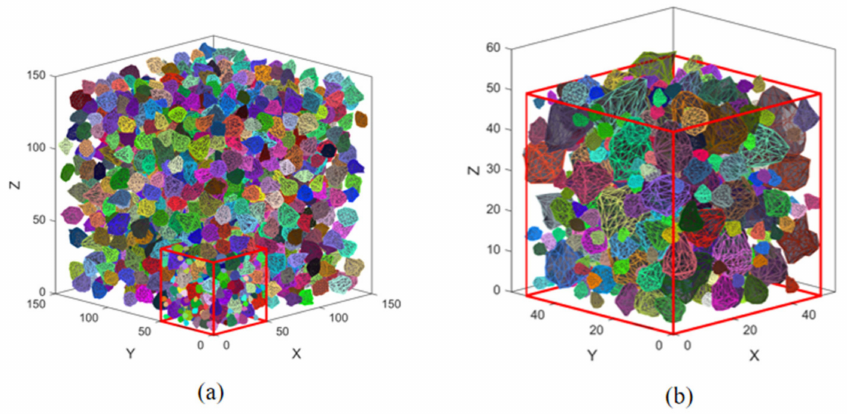
Figure 2. Generated mesoscopic aggregates library, ( a ) aggregates with particle size of 12–20 mm; ( b ) aggregates with particle size of 4–20